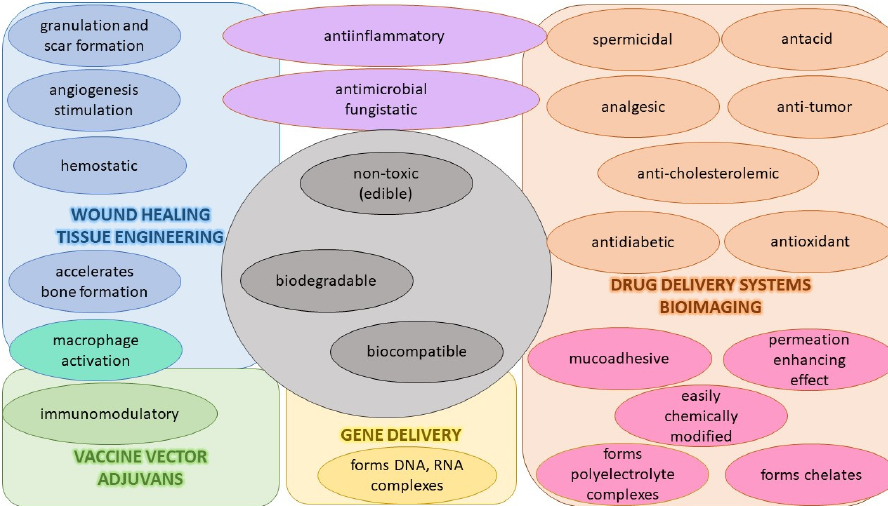
Figure 4. Properties of chitosan and its biomedicinal applications. Chitin and its deacetylated derivative, CS, are a family of linear polysaccharides com- posed of varying amounts of ( β 1 → 4) linked residues of N -acetyl-2 amino-2-deoxy-D-glu- cose (glucosamine, GlcN) and 2-amino-2-deoxy-D-glucose ( N -acetyl-glucosamine, Glc- NAc) residues [165]. The presence of the amino group at the C-2 position of the glucosa- mine unit strengthens the functional and structural properties of CS. This amino group represents its cationic nature and imparts inherent properties of wound healing, antimi- crobial activity, and most importantly, mucoadhesiveness, making it a good carrier mate- rial in drug delivery systems. It has a pKa of 6.5, and it is insoluble in water but soluble in aqueous acidic media. It is protonated and polycationic in nature and forms complexes with diverse anions such as lipids, proteins, DNA, alginate, pectin, and poly(acrylic acid). The physicomechanical properties (solubility, toxicity, hydrophobicity) of CS depend on the degree of deacetylation and molecular weight of CS, which depend on the source of chitin [23]. The mucoadhesive property of CS is attributed to its cationic character. The mucous membrane is composed of mucin glycoprotein and has anionic functionalities in the form of sialic acid and sulfonic acid. The cationic group in CS and these anionic acids in the mucous result in ionic interactions conferring mucoadhesive attributes to CS. The muco- adhesion increases with the degree of deacetylation and its molecular weight and de- creases with an increase in crosslinking. This attribute promotes its adherence to the sur- face of the gastrointestinal tract and upper respiratory tract and is a tool in retaining this carrier for a prolonged time, achieving sustained release of drug payloads [170]. CS, being positively charged and engaged in interaction with the mucus membrane, opens the tight junctions between the cells (by reducing the transepithelial electrical re- sistance), promoting passage through the mucosal cells and enhancing drug permeation.